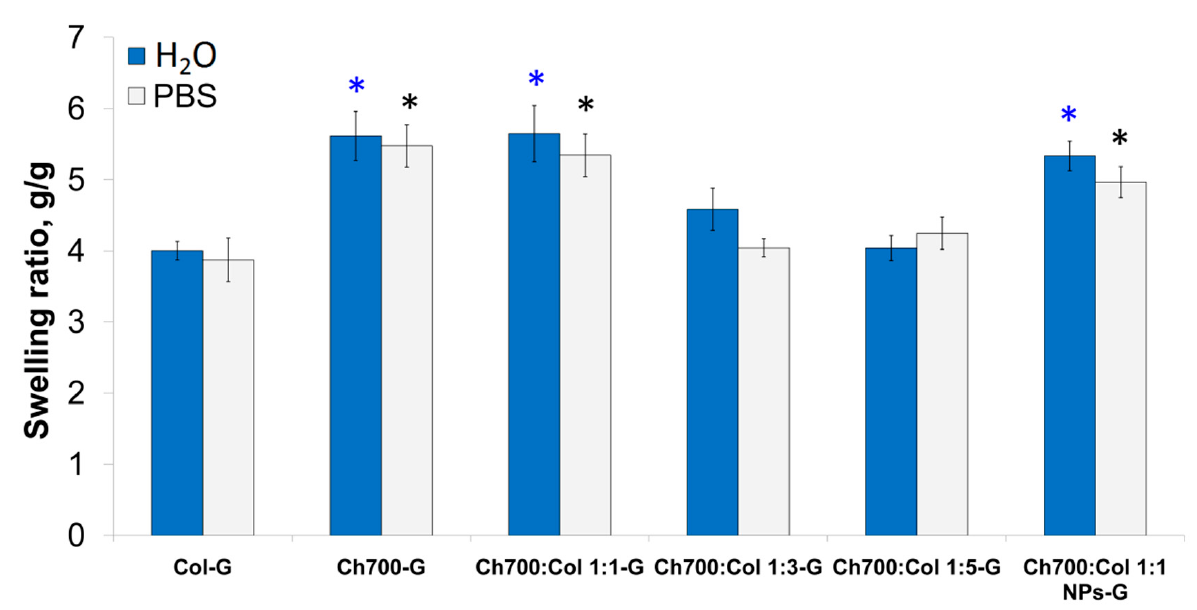
Figure 2. Swelling of gels cross-linked with 0.03% genipin in water or in PBS after 24 h of incubation. The statistical significance was evaluated using the Student’s t -test: Blue stars correspond to— p < 0.05 vs. Col-G in water, black stars to— p < 0.05 vs. Col-G in PBS.